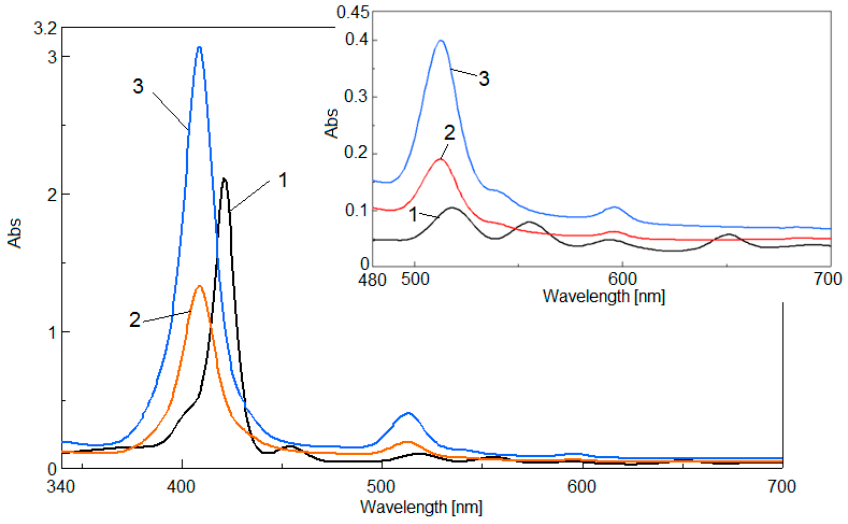
Figure 1. UV-vis monitoring of the metalation reaction in chlorobenzene: 1—porphyrin base; 2—Pt-metalloporphyrin generation after 15 min reflux; 3—Pt-metalloporphyrin at the end of the reaction. The Q bands in details.